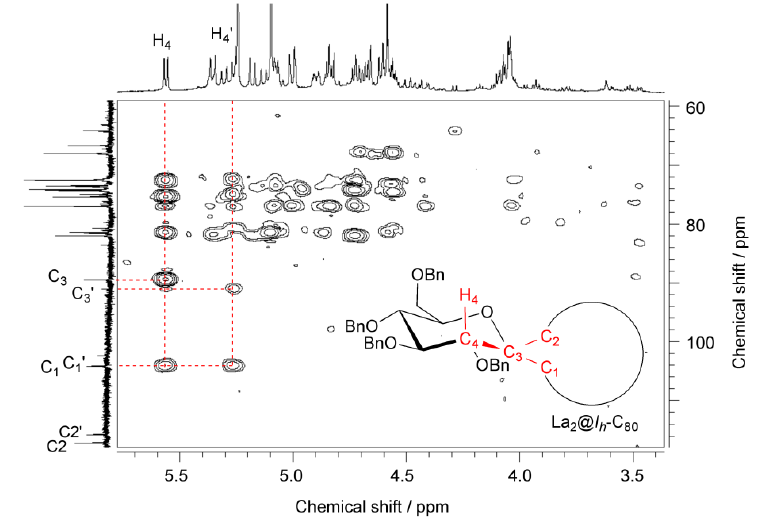
@ I -C (Ad) (green), and La 2 h 80